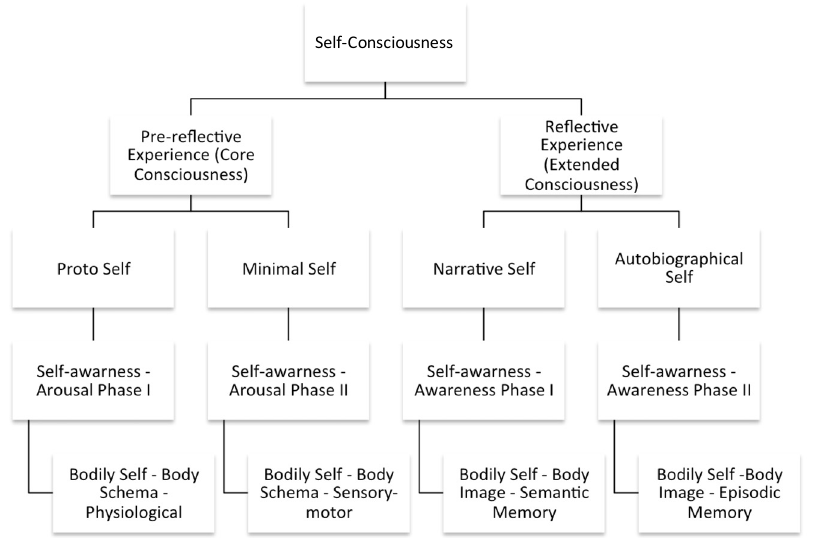
Figure 4. Fluxogram of the neurophenomenological method. A fluxogram is presented to systemize the intervention Protocol and the two phases of the experimental procedure: the Arousal Phase and the Awareness Phase. The correspondence to the bodily self and body schema [118] induced in each phase is represented. This figure was created following the work of the authors Hipólito and Martins [49].